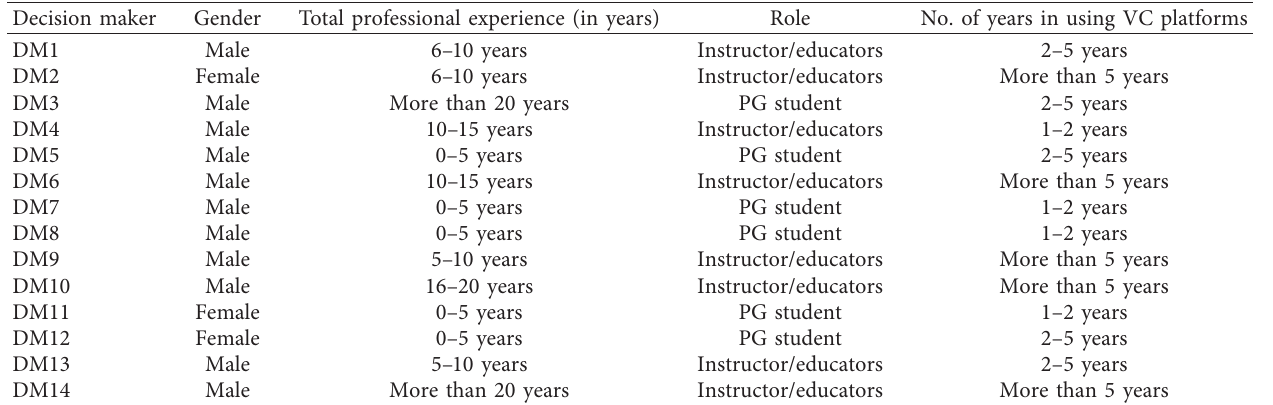
Table 3: Respondents’